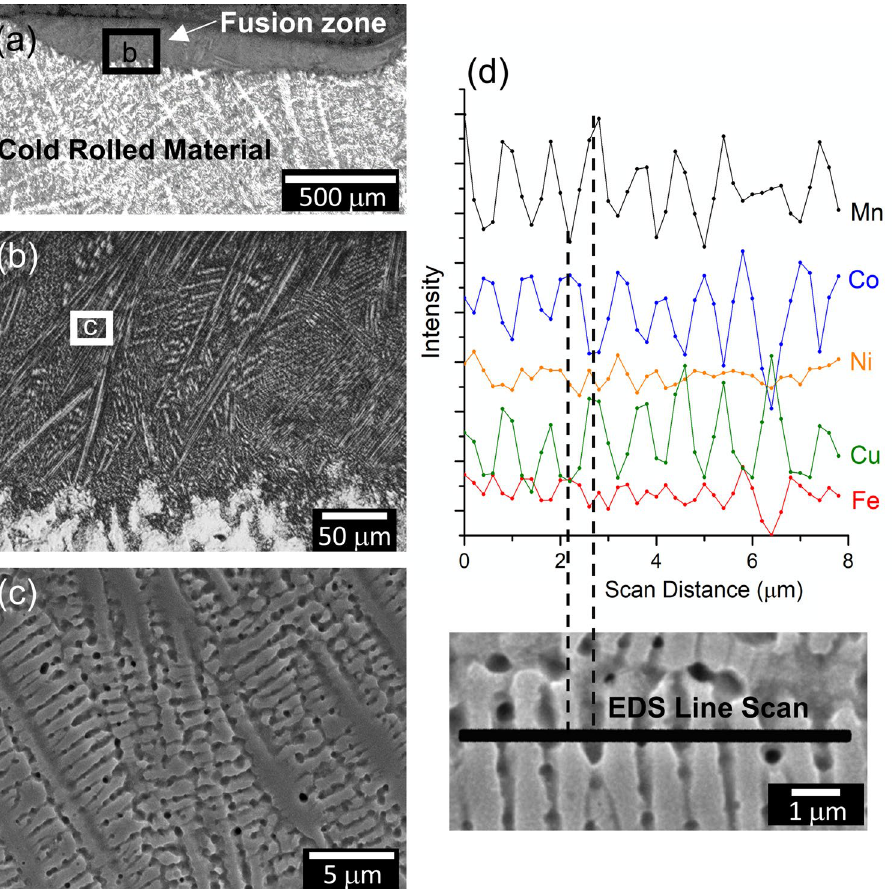
Figure 2. Microstructure of the MPCA specimen after laser-melting. ( a , b ) Etched optical micrographs displaying ( a ) the full extent of fusion zone and ( b ) a closer view of the dendritic microstructure; ( c ) Secondary electron image illustrating primary and secondary dendrite arms; and ( d ) EDS line scan result and magnified view of the scan location across a series of secondary dendrite